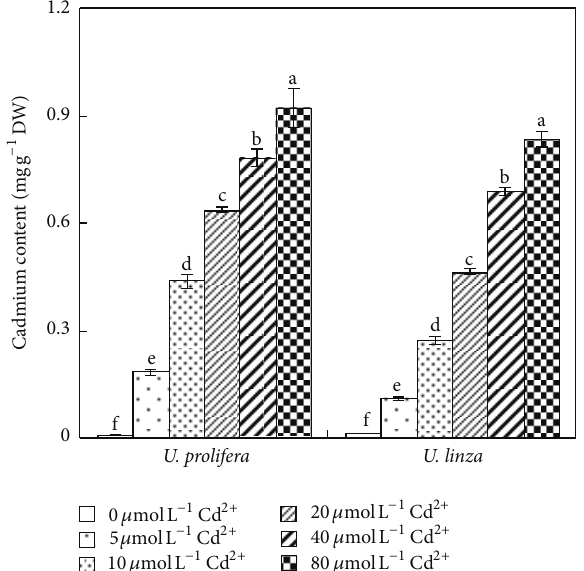
Figure 3: Effects of different concentrations of Cd 2+ (0, 5, 10, 20, 40, and 80 𝜇 molL −1 ) on cadmium concentration of U. prolifera and U.